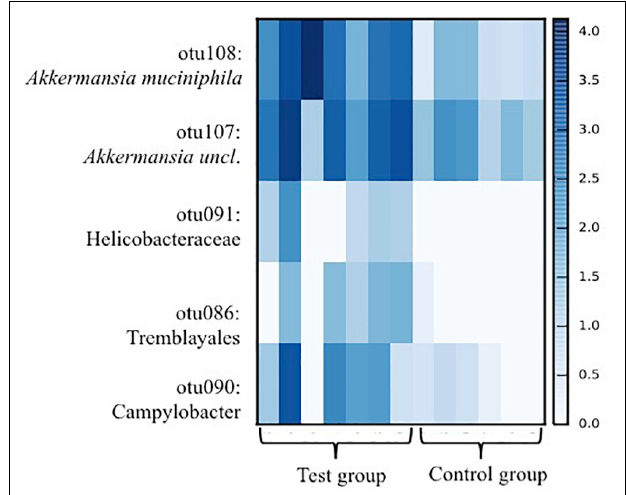
FIGURE 3 | Heat-map showing taxa in which significant differences ( p < 0.05) between foals fed either a test supplement enriched with oligosaccharides or a control diet as detected in ANCOM analysis based on 16S rRNA gene amplicon sequences from fecal samples collected from foals 49 days after birth. Scale on the right indicates log abundance.